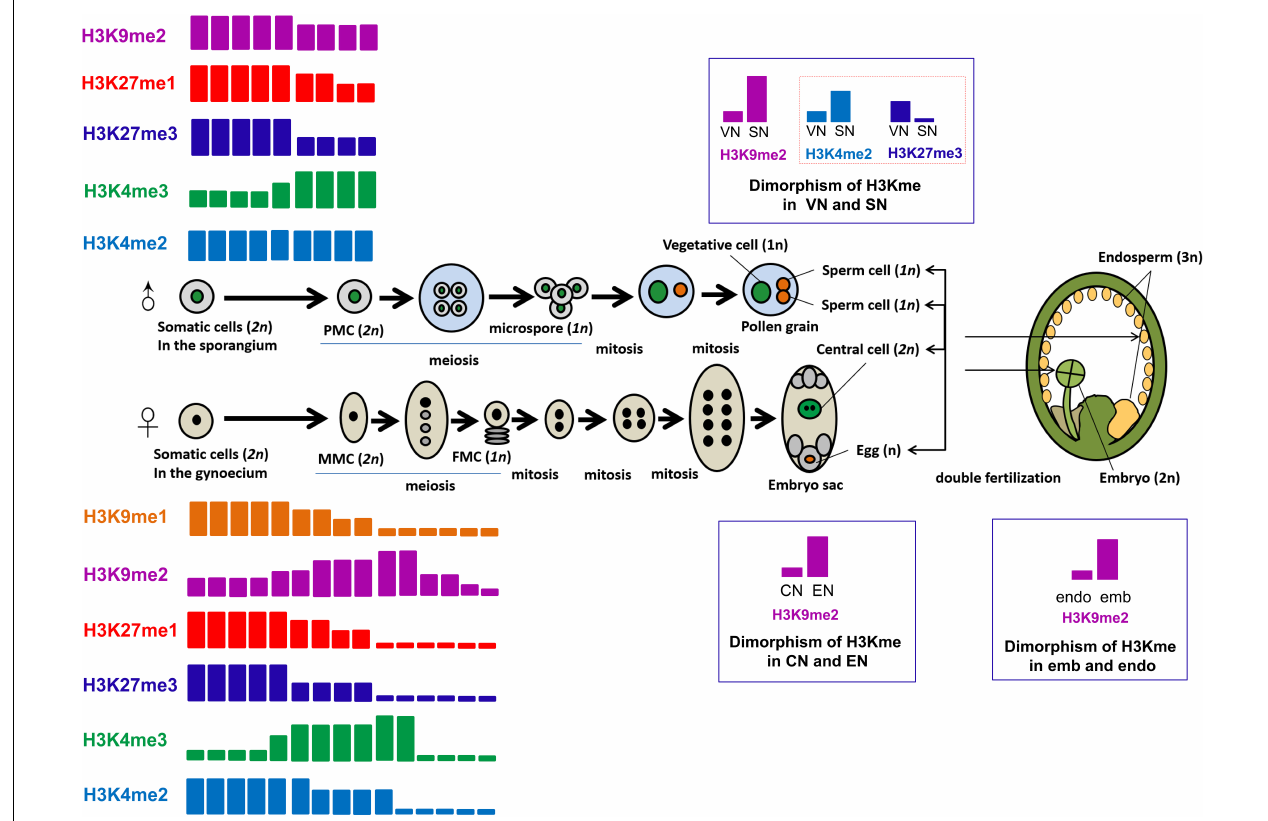
FIGURE 3 | Dynamics of H3 lysine methylation during plant sexual reproduction. The process of plant sexual reproduction, including sporogenesis, gametogenesis, embryo- and endosperm-genesis, as well as the dynamics of H3 lysine methylation during plant sexual reproduction, are summarized in this figure. Differently colored rectangles represent different H3 methylation marks, including the orange rectangle for H3K9me1, the purple rectangle for H3K9me2, the red rectangle for H3K27me1, the blue rectangle for H3K27me3, the green rectangle for H3K4me3, and the light blue for H3K4me2. The height of the rectangles represents the relative enrichment of a certain methylation mark. In the flower, pollen mother cells (PMCs) ( 2n ), differentiated from somatic cells in the sporangium, undergo meiosis to form four microspores ( 1n ). Each microspore undergoes an asymmetrical division to generate one vegetative cell and one generative cell, which then divides to form two sperm cells ( 1n ). The pair of sperm cells and the vegetative cell are linked to form the mature pollen grain. The sperm nucleus (SN) and vegetative nucleus (VN) have dimorphic pattern in their chromatin condensation, and the chromatin of SN is more compacted, accompanied by much more deposition of H3K9me2, compared with that in VN. Paradoxically, the transcriptionally permissive mark H3K4me2 is enriched and the repressive mark H3K27me3 is globally depleted in SN. The megaspore mother cells (MMCs) ( 2n ) are generated from somatic cells in the gynoecium. MMCs undergo meiosis to generate four haploid spores ( 1n ). The surviving megaspore, functional megaspore cell (FMC) ( 1n ), undergoes three rounds of nuclear divisions to generate an eight-nuclei containing syncytial female gametophyte (embryo sac). After cytokinesis, the mature female gametophyte consists of the egg cell, the central cell, and accessory cells (antipodals and synergids). The egg nucleus (EN) exhibits more pronounced condensation, with significantly higher H3K9me2 deposition, compared to the central nucleus (CN). The egg cell and the central cell are each fertilized by one sperm cell to produce the diploid embryo (2n) and the triploid endosperm (3n), respectively. The dimorphic chromatin status present between the embryo (emb) and the endosperm (endo), which might be inherited from the female gametes after fertilization, with the embryo (emb) having highly condensed chromatin compared to the endosperm (endo), characterized by obviously lower H3K9me2 accumulation in emb than in